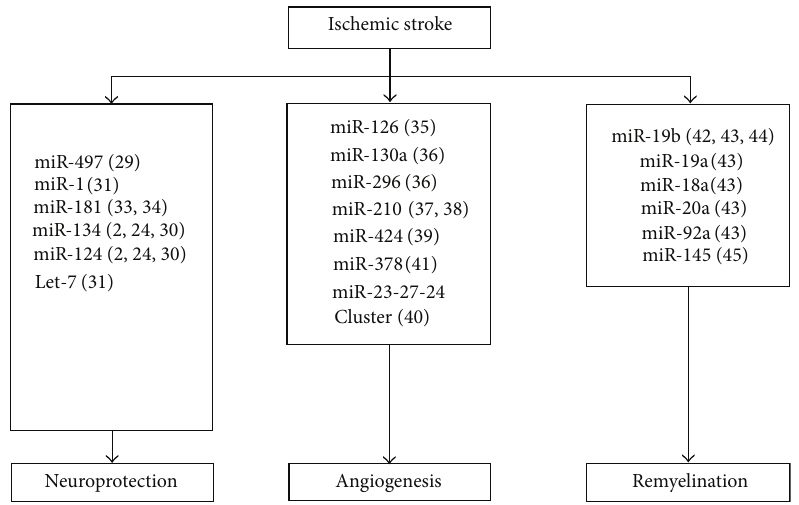
Figure 1: Regulation of miRNAs in ischemic stroke. Bracket indicates reference